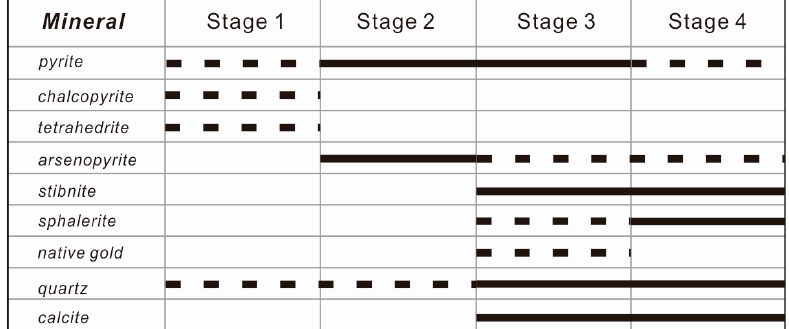
Figure 4. Paragenetic sequence of the Zaozigou deposit interpreted from cross-cutting relationships, ore textures and sulfide assemblages. The black full lines indicate high abundance and the black dashed lines represent minor